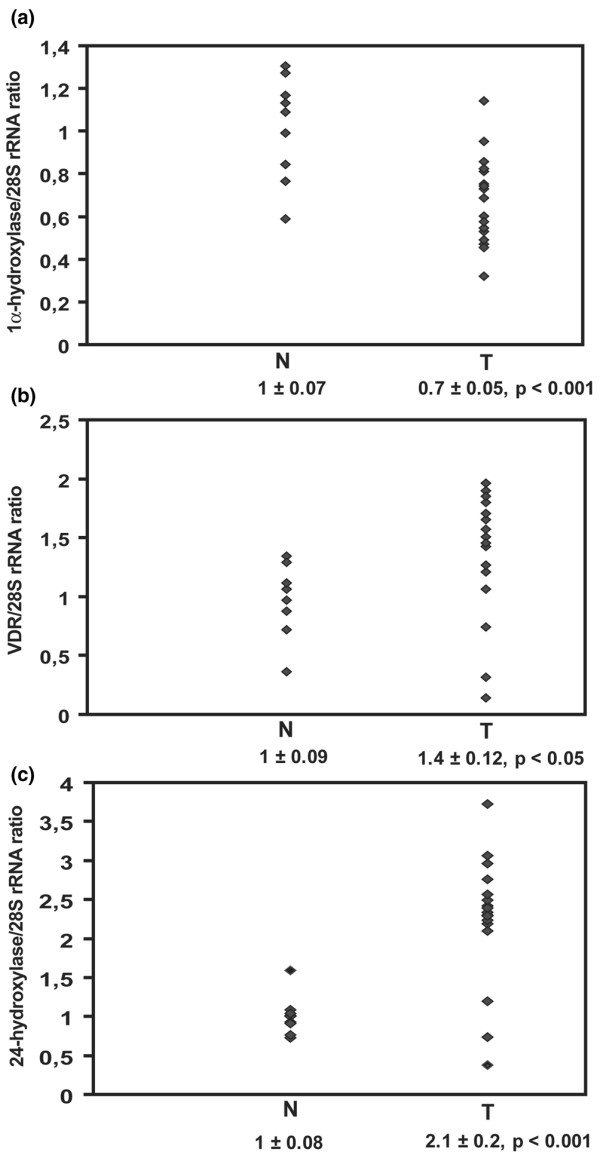
(a) Determination of 1α-hydroxylase, (b) VDR and (c) 24-hydroxylase mRNA expression in normal (N) breast tissue specimens (n = 10) and breast cancer (T) specimens (n = 19) by semiquantitative RT-PCR. The expression was related to the 28S rRNA level in each sample. The results are presented as mean ± standard error of the mean. and comparisons between the group means were analyzed by Student's t-test.